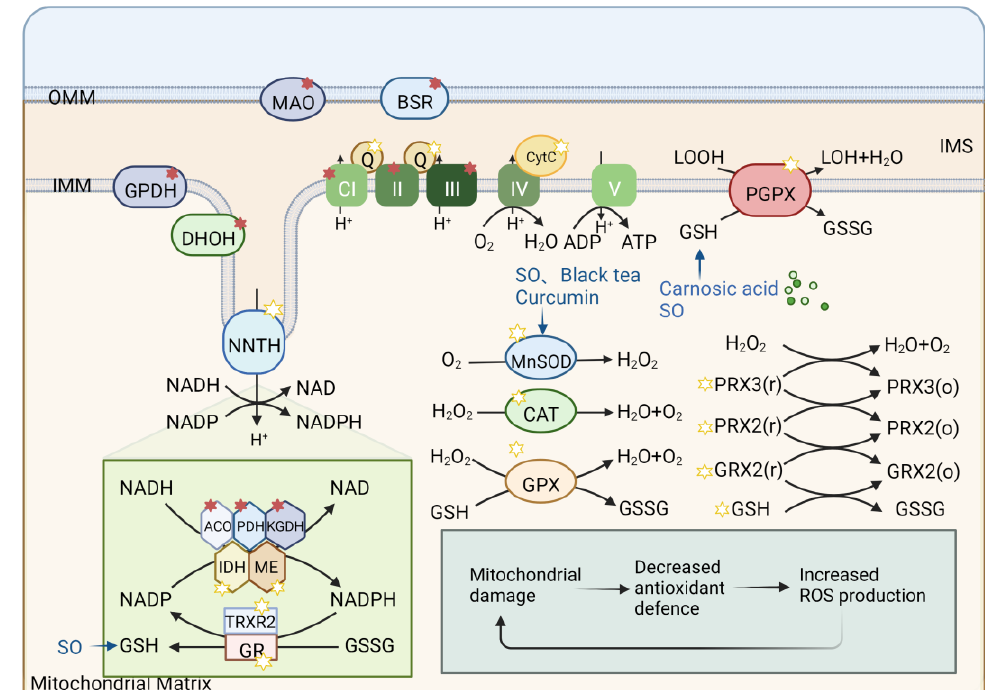
Figure 4. Oxidative metabolism and antioxidant system in mitochondria. The figure shows the contents and processes in mitochondria that are mainly involved in the production of ROS (red stars) and antioxidant defense systems (yellow stars). Enzymes that produce ROS are: tricarboxylic acid (TCA) cycle enzymes aconitase (ACO), α -ketoglutarate dehydrogenase (KGDH), pyruvate dehydrogenase (PDH), glycerol-3-phosphate dehydrogenase (GPDH), CI, CII, and CIII in ETC, antioxidant defense systems are: Q, CytC, d glutathione (GSH) in ETC, interacting, glutaredoxin (GRX2), thioredoxin (TRX2), peroxiredoxins (PRX3/5), etc., Enzyme manganese superoxide dismutase (MnSOD), catalase (Cat), glutathione peroxidase (GPX), isocitrate dehydrogenase (IDH) and malic enzyme (ME), etc., Oxidant membrane protein nicotinamide nucleotide transhydrogenase (NNTH), phospholipid hydroperoxide glutathione perpx (PGPX), etc. Some natural drugs have been shown to have an effect on the REDOX system.